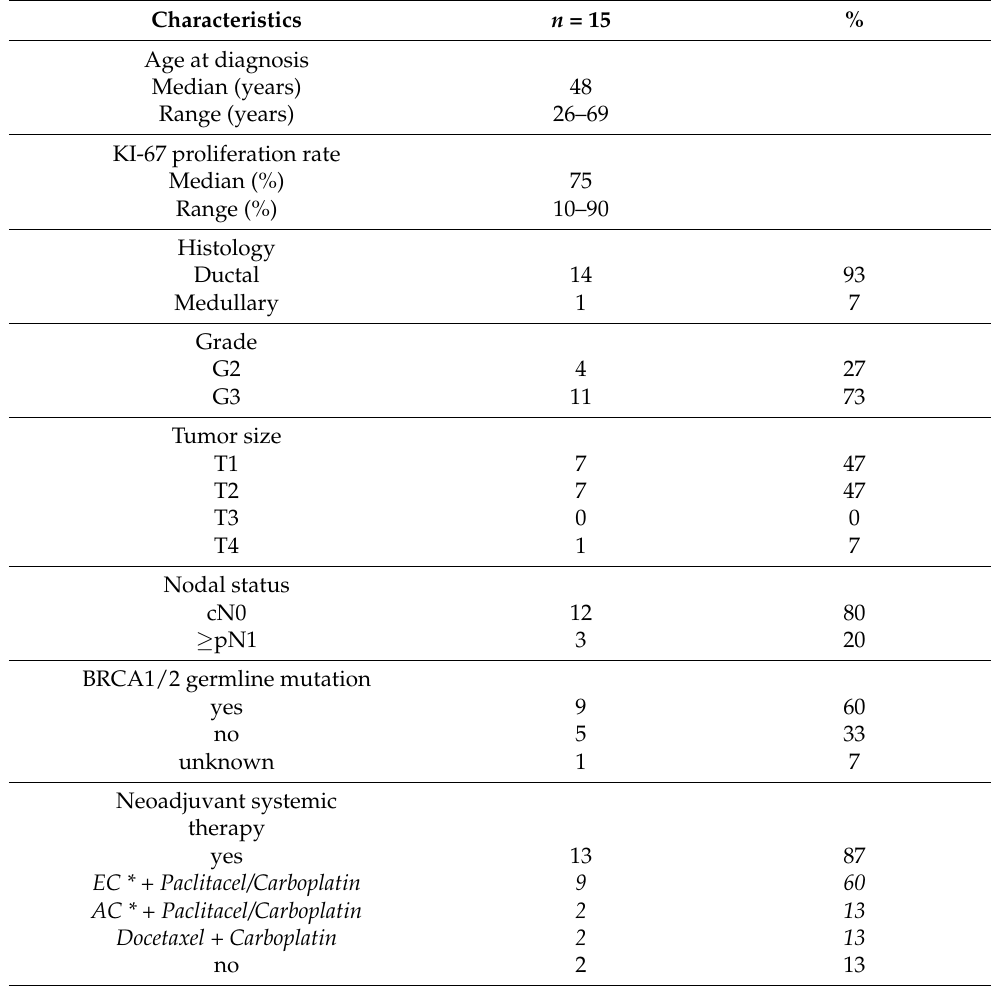
Table 1. Patient characteristics at